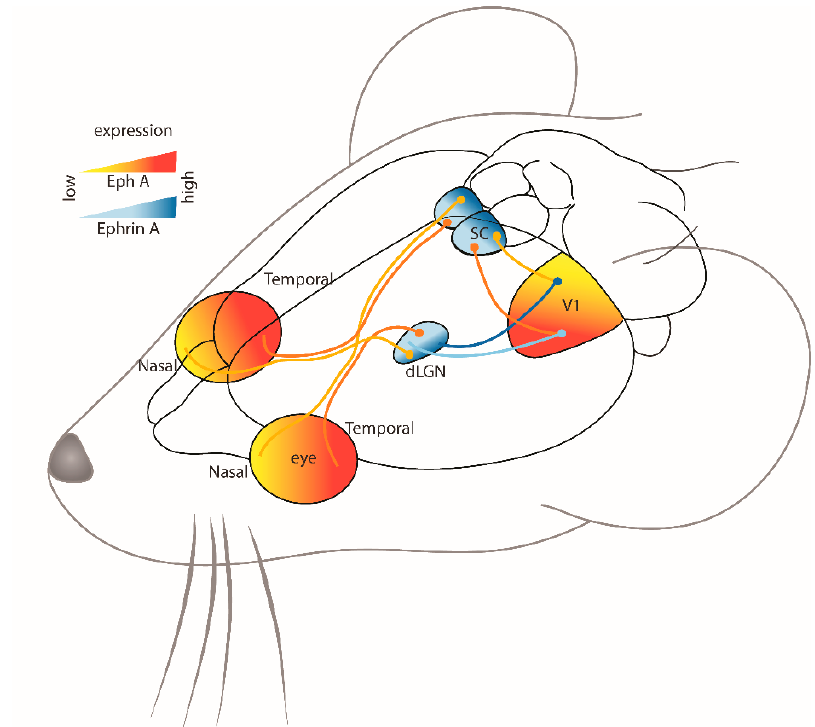
Figure 1. Schematic representation of the visual system circuitry guided by Eph-ephrin gradients in di ff erent regions of the adult mouse brain. The endpoints of the projections are represented by a circle (dLGN-dorsolateral geniculate nucleus; SC-superior colliculus; V1-primary visual system).